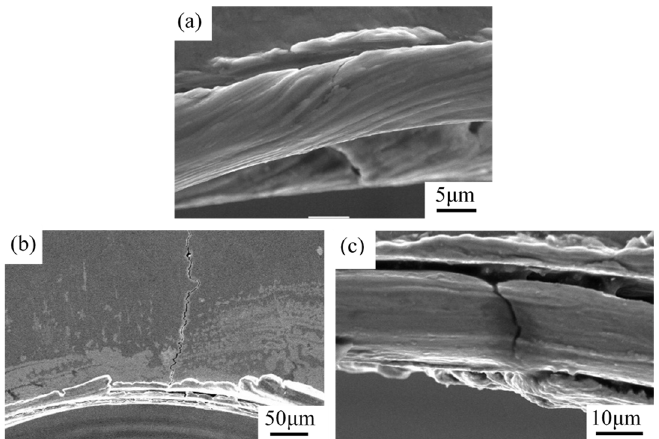
Figure 6. Secondary fatigue cracks found at an artificial defect ( d = 0.73 mm, N = 8.0 × 10 4 , speci- men Type II in Table 2). ( a ) Macroscopic view; ( b ) magnified view of area A in Figure ( a ); ( c ) mag-